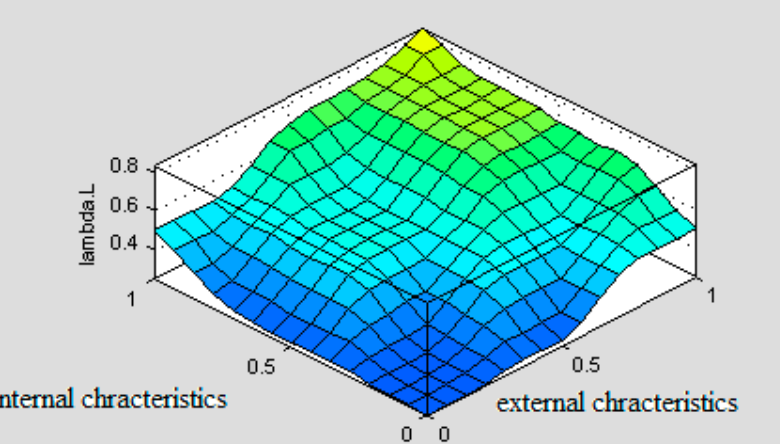
Figure 7. Simulation results for intensity of accidents caused by human mistakes depending on external and internal characteristics.